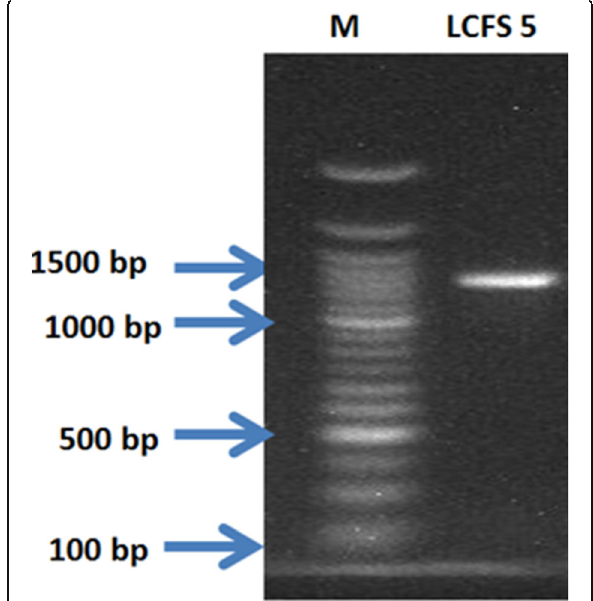
Fig. 6 The PCR product obtained via electrophoresis on 1.5% agarose {M, marker; LCFS 5; genomic DNA of Aspergillus niger LCFS 5 (MZ448204)}